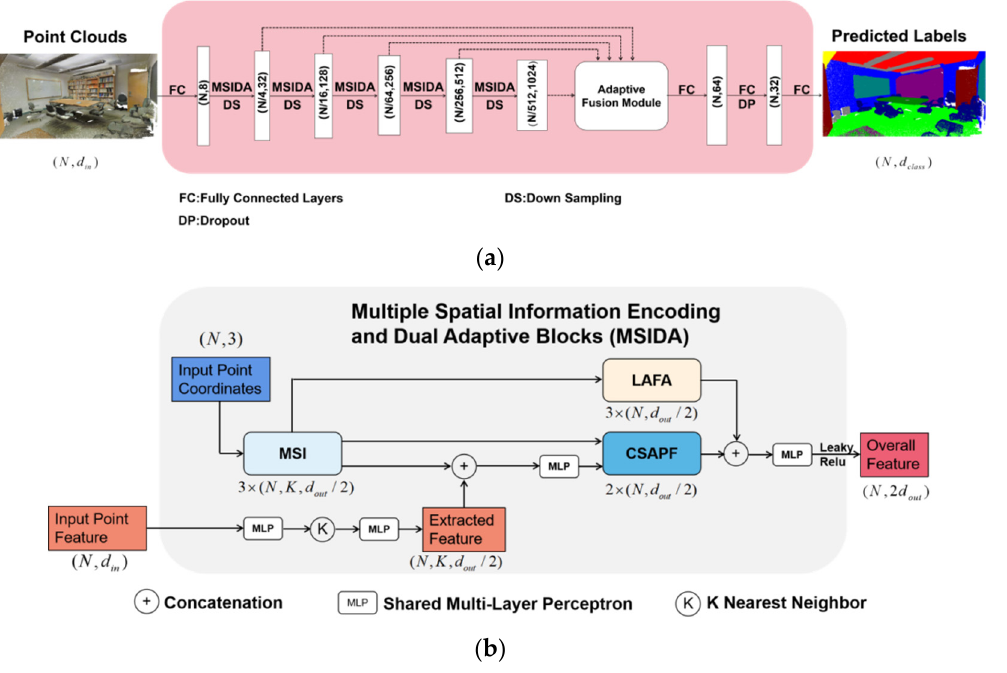
Figure 2. Our proposed method. ( a ) The framework of MSIDA-Net. ( b ) The detailed structure of the MSIDA module.